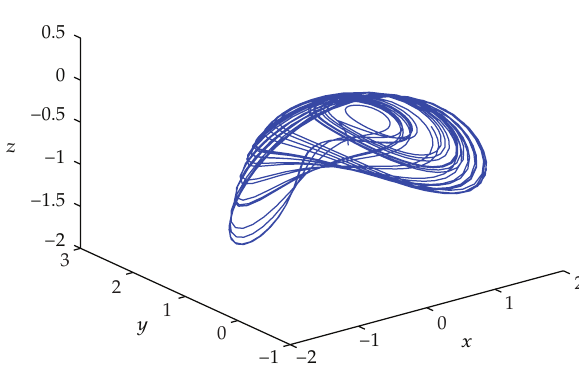
Figure 1: Chaotic attractor of system (cid:5) 2.1 (cid:6)